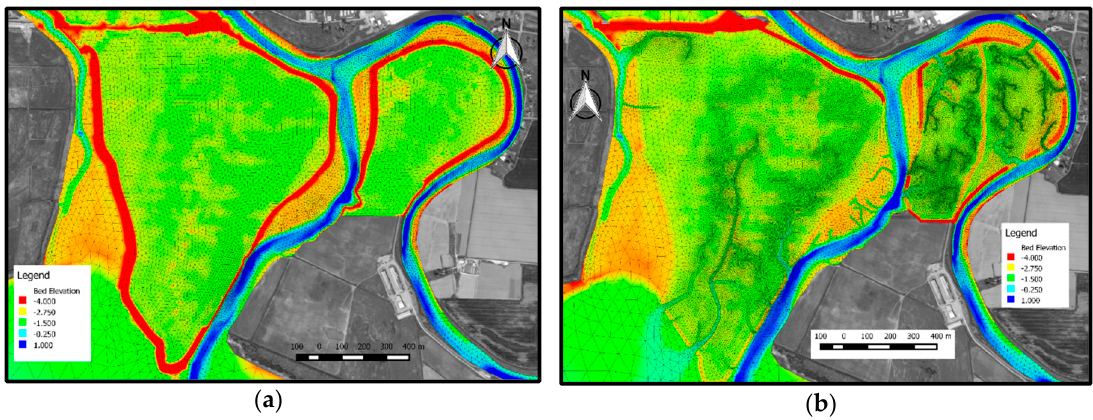
Figure 8. ( a ) Baseline scenario grid overlaying the bed elevation map. ( b ) Preferred restoration alternative scenario grid overlaying the bed elevation map.